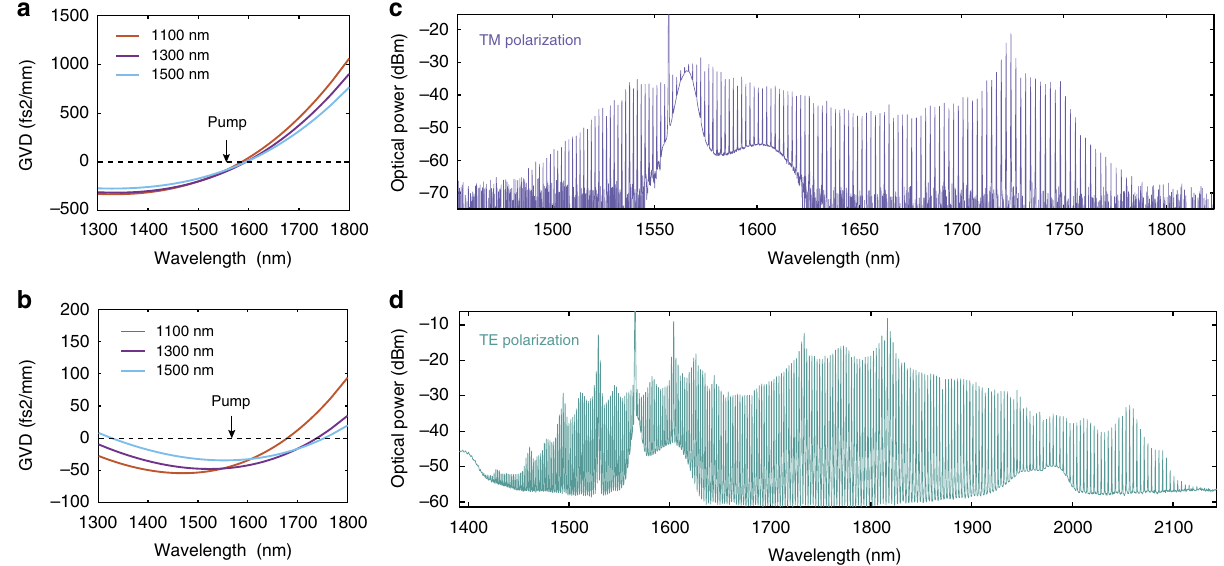
Fig. 2 Broadband frequency comb generation. a , b Numerically simulated group-velocity dispersions (GVD) at telecom wavelengths for LN waveguides with different top widths. Anomalous dispersions (GVD < 0) can be achieved for both transverse-magnetic (TM) ( a ) and transverse-electric (TE) ( b ) modes. c , d Generated frequency comb spectra when the input laser is tuned into resonance with either TM ( c ) or TE ( d ) modes at a pump power of ~300 mW in the bus waveguide. The generated combs have a line spacing of ~ 250 GHz, and span ~300 nm ( c ) and ~700 nm ( d ) for TM and TE modes,